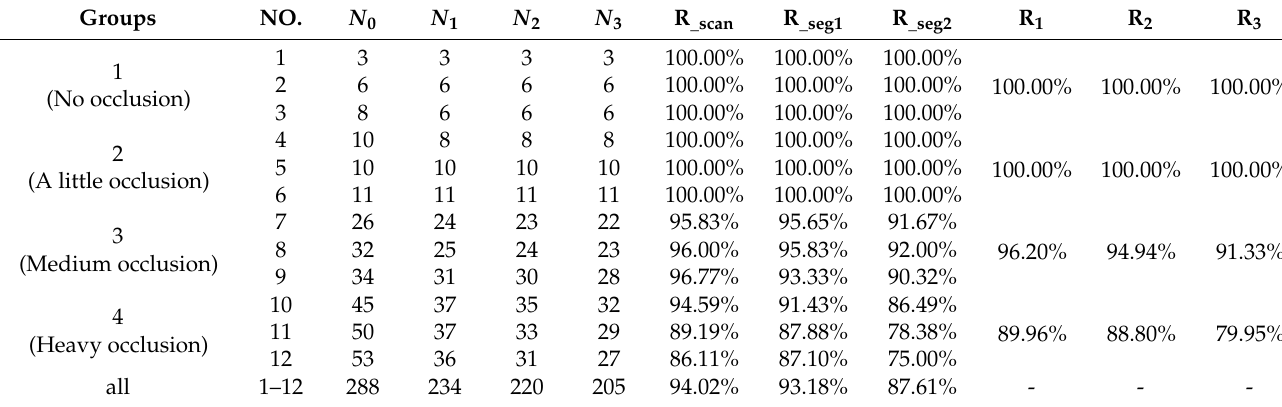
Table 3. Accuracy of data scanning and individual leaf segmentation of typical leaf samples. NO. is the number of plants. N 0 is the number of leaves on the plant. N 1 , N 2 , and N 3 are the numbers of manually selected, well scanned, and automatically selected typical leaf samples. R 1 , R 2 , and R 3 are the average value of R _scan , R _seg1 , and R _seg2 for each